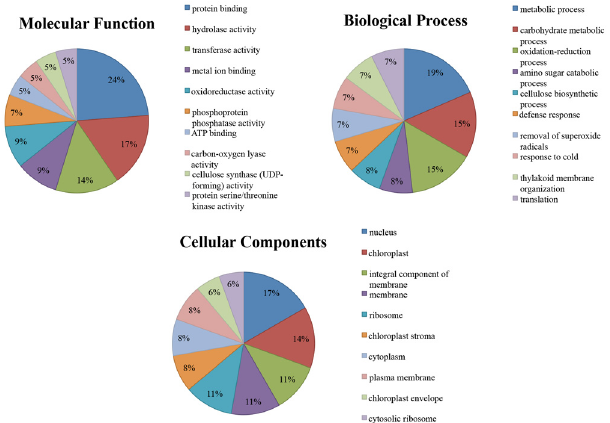
Fig 12. The top ten GO terms for the three GO categories for the targets identified for the novel cassava miRNAs.